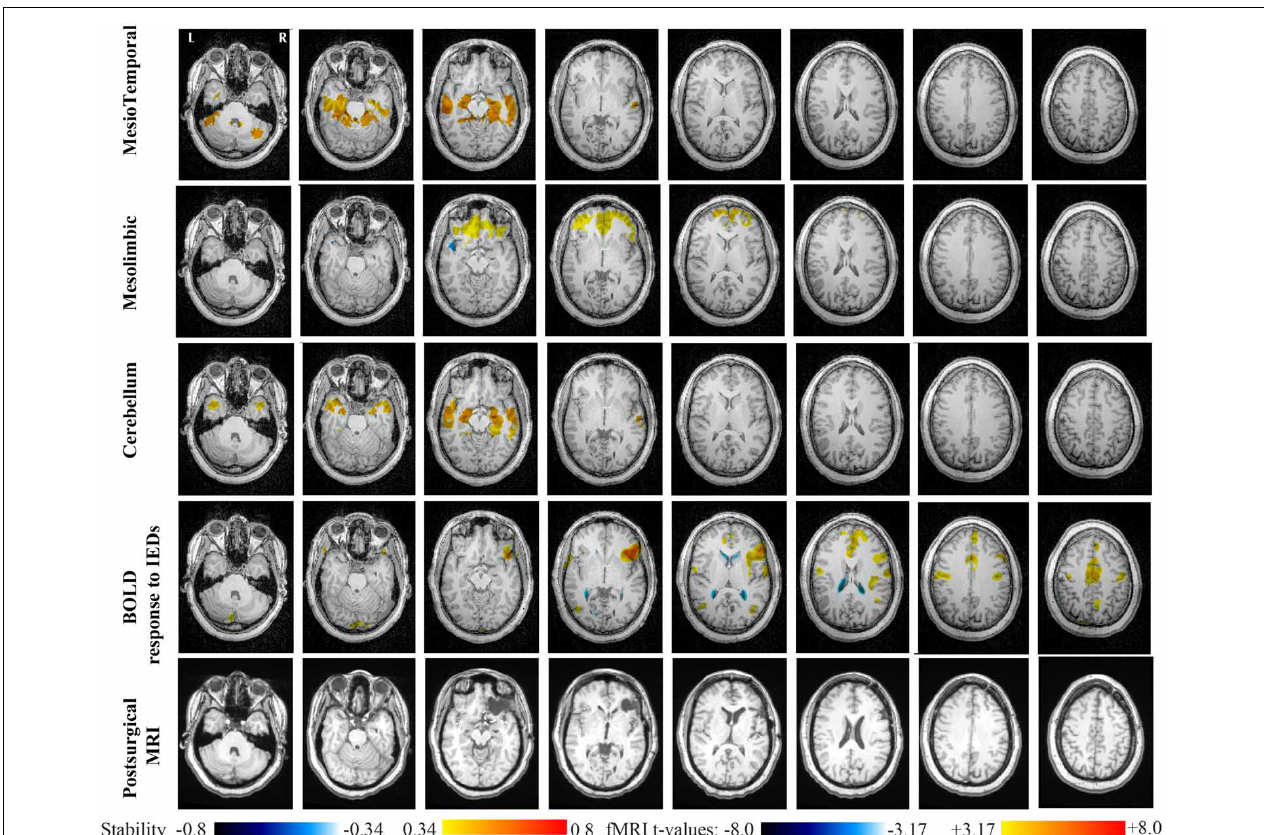
FIGURE 6 | Evaluation of DANI on Patient 1 with right Orbito-Frontal epilepsy. Results are presenting most salient stability changes observed in Cmap n followed by a t-map of the BOLD response to epileptic discharges and a postsurgical T1 MRI, all resampled in the native anatomical MRI space of the patient. Most salient stability changes observed for Cmap n of